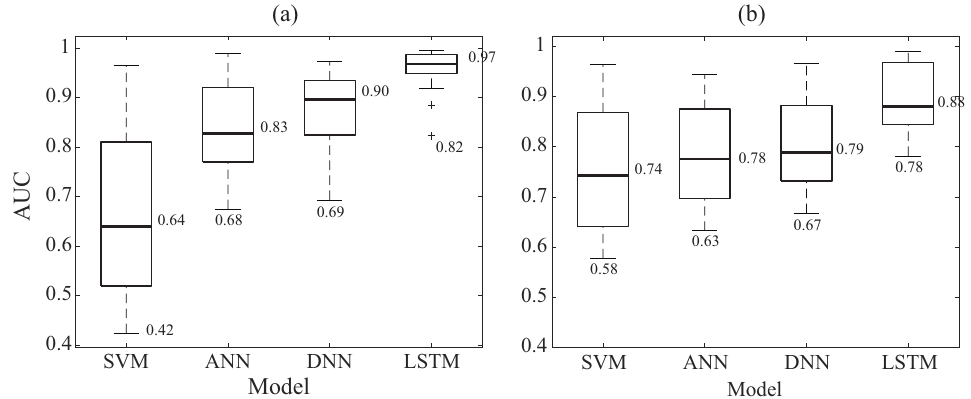
Figure 10. Box plot of the proposed model and the conventional model. ( a ) Result of the set1 DB, ( b ) Result of the set2 DB. The line at the center of the box represents median, and the top and bottom edges of the box represent the 75% and